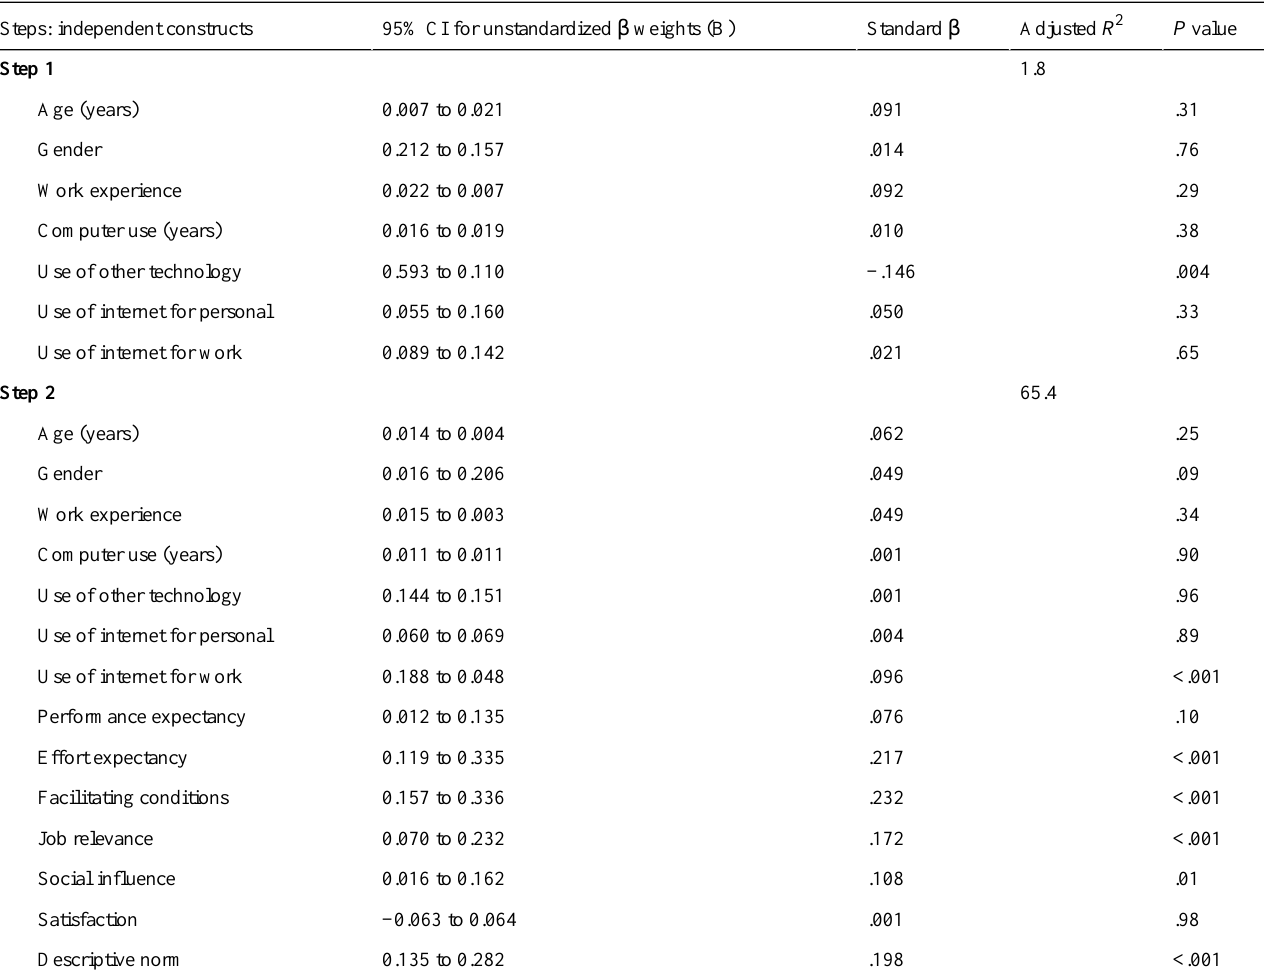
Table 2. Predictors of intentions to use the electronic health record